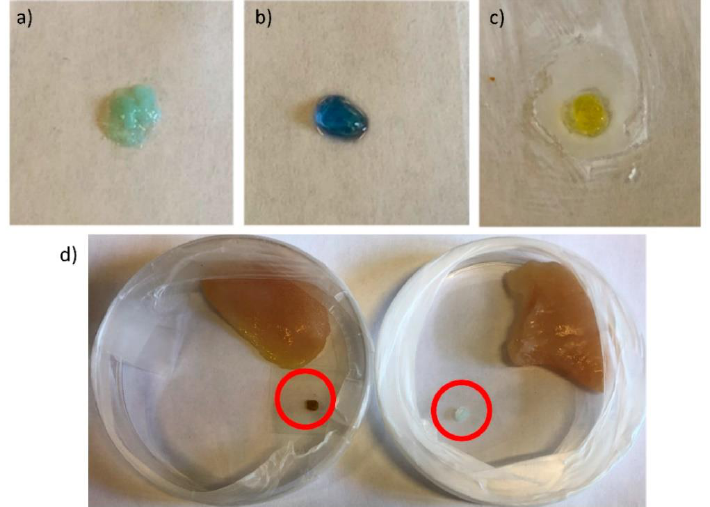
Figure 9. Application of peptide-Cu(II) gel for the monitoring of food freshness. Images of pyrene- peptide-Cu 2+ gel ( a ) as prepared, ( b ) after exposure to ammonia vapors, and ( c ) after exposure to HCl vapors. ( d ) Colorimetric responses of the gel (red circles) when exposed to chicken meat stored at 25 °C (left) and 4 °C (right). Reproduced from [117].